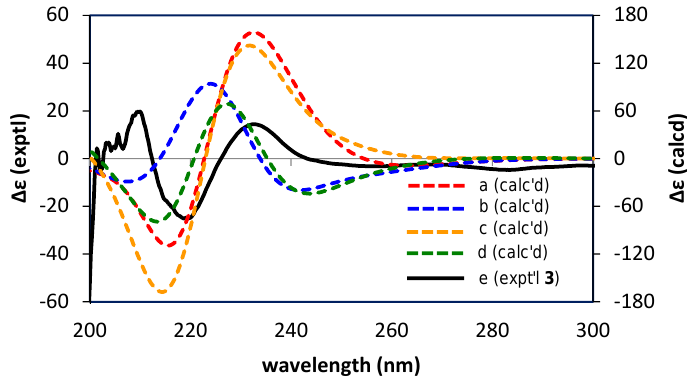
Figure 9. Calculated (a–d) and experimental (e) ECD spectra of prodelphinidin trimer thioether ( 3 ).